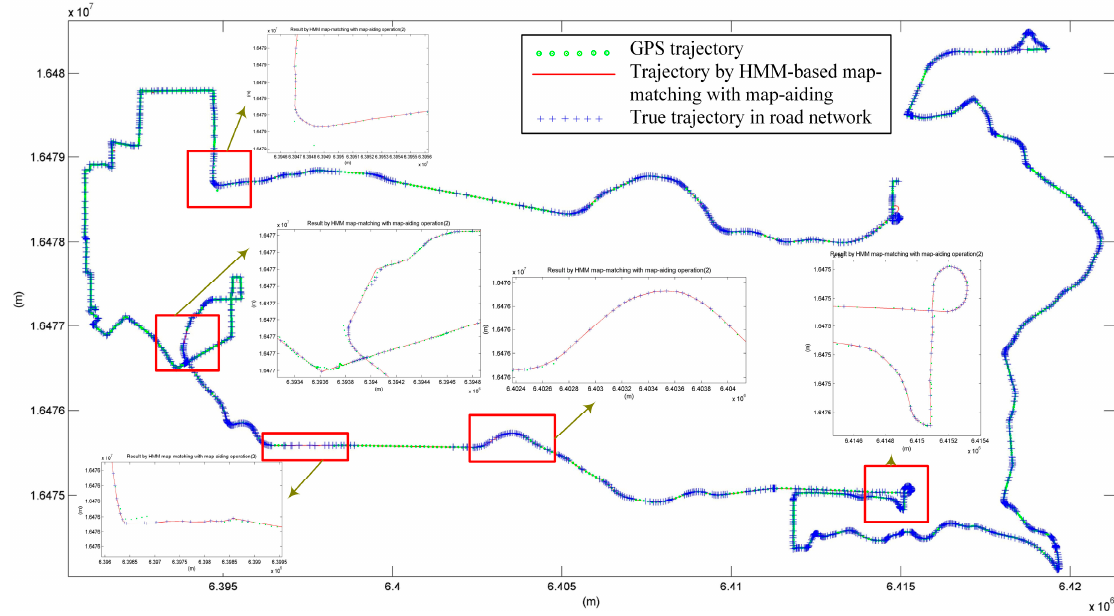
Figure 11. Result of HMM-based map-matching operation.